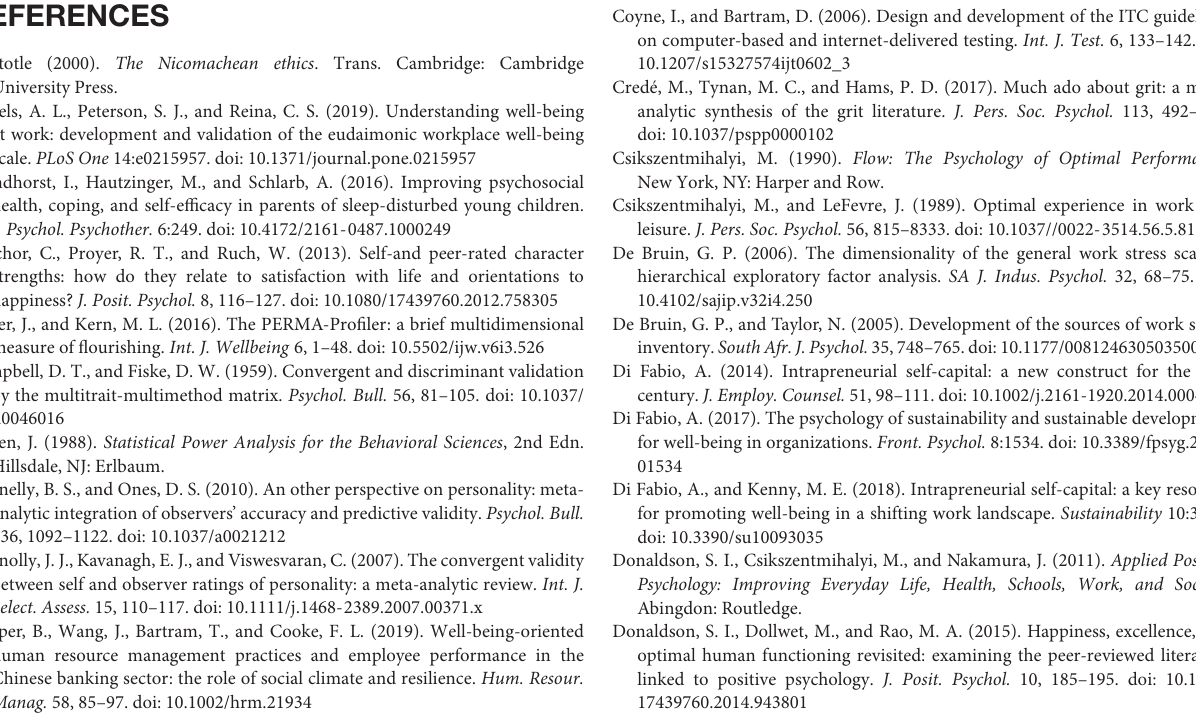
TABLE S1 | Means, standard deviations, and correlations of orientations to happiness (OTH) and well-being at work with gender and age. TABLE S2 | Collinearity analyses for our multiple regression models predicting types of work satisfaction (General, Content-related, Resigned) and work stress from age, gender, and orientations to happiness (Pleasure, Engagement,